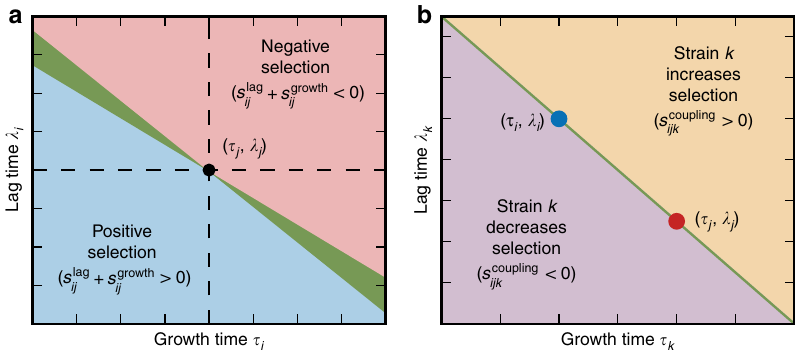
Fig. 2 Selection in lag-growth trait space. a Diagram of selection on lag and growth for strain i relative to strain j . Trait values of strain j are marked by a black dot in the center. If the traits of strain i lie in the blue region, i is positively selected over strain j , while if strain i lies in the red region, it is negatively selected. If strain i lies in the green region, it is conditionally neutral with j (positively selected at some densities and negatively selected at others). b Diagram of lag and growth times for strain k relative to two other strains i (blue) and j (red). If the traits of strain k lie in the orange region (above the straight line joining i and j ), then its coupling term s coupling ijk (Eq. 3) increases the total selection coef fi cient of i over j , while if k lies in the violet region (below the straight line), then it decreases the selection of i over